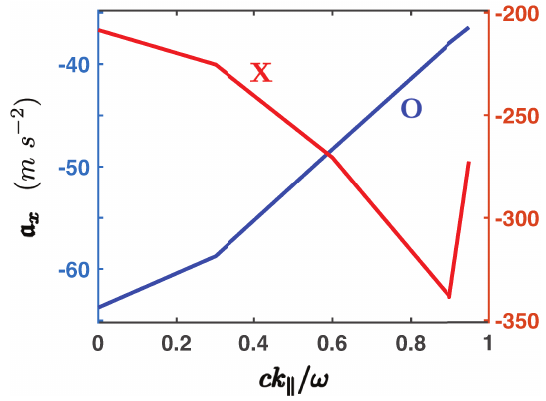
Figure 7. The acceleration of a filament induced by the radiation force of the O mode (left scale) and the X mode (right scale) as function of the index of refraction along the direction of the magnetic field. The density inside the filament is greater than the background density. The negative acceleration means that the filament is being pulled in towards the RF source. For ck (cid:107) /ω = 0 . 95 the X mode is evanescent inside the filament.